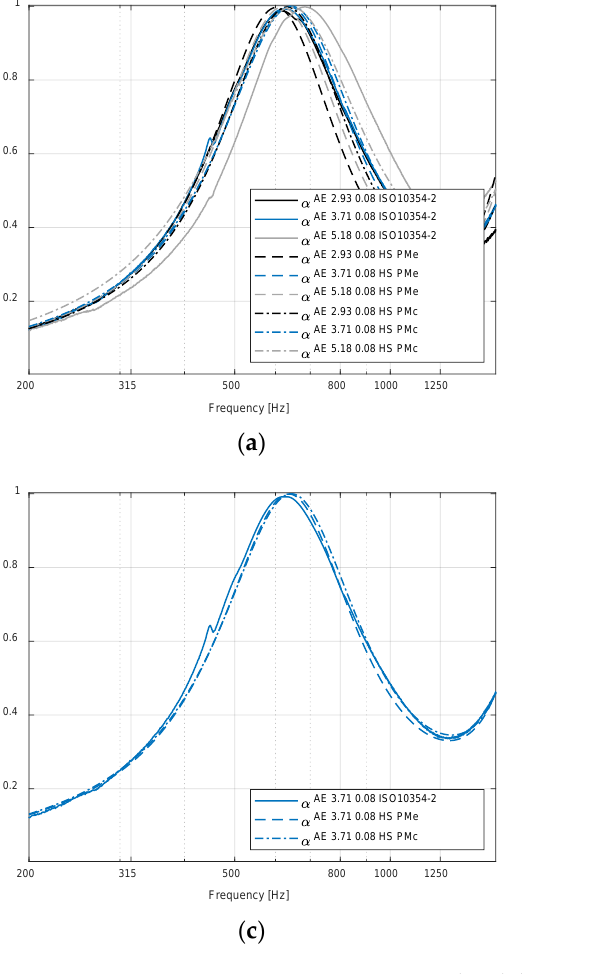
Figure 10. Experimental and theoretical results of the sound absorption coefficient curves, for normal incidence waves, ( a ) for all 8 cm thick samples. Figure ( b – d ) show the results by type of sample.